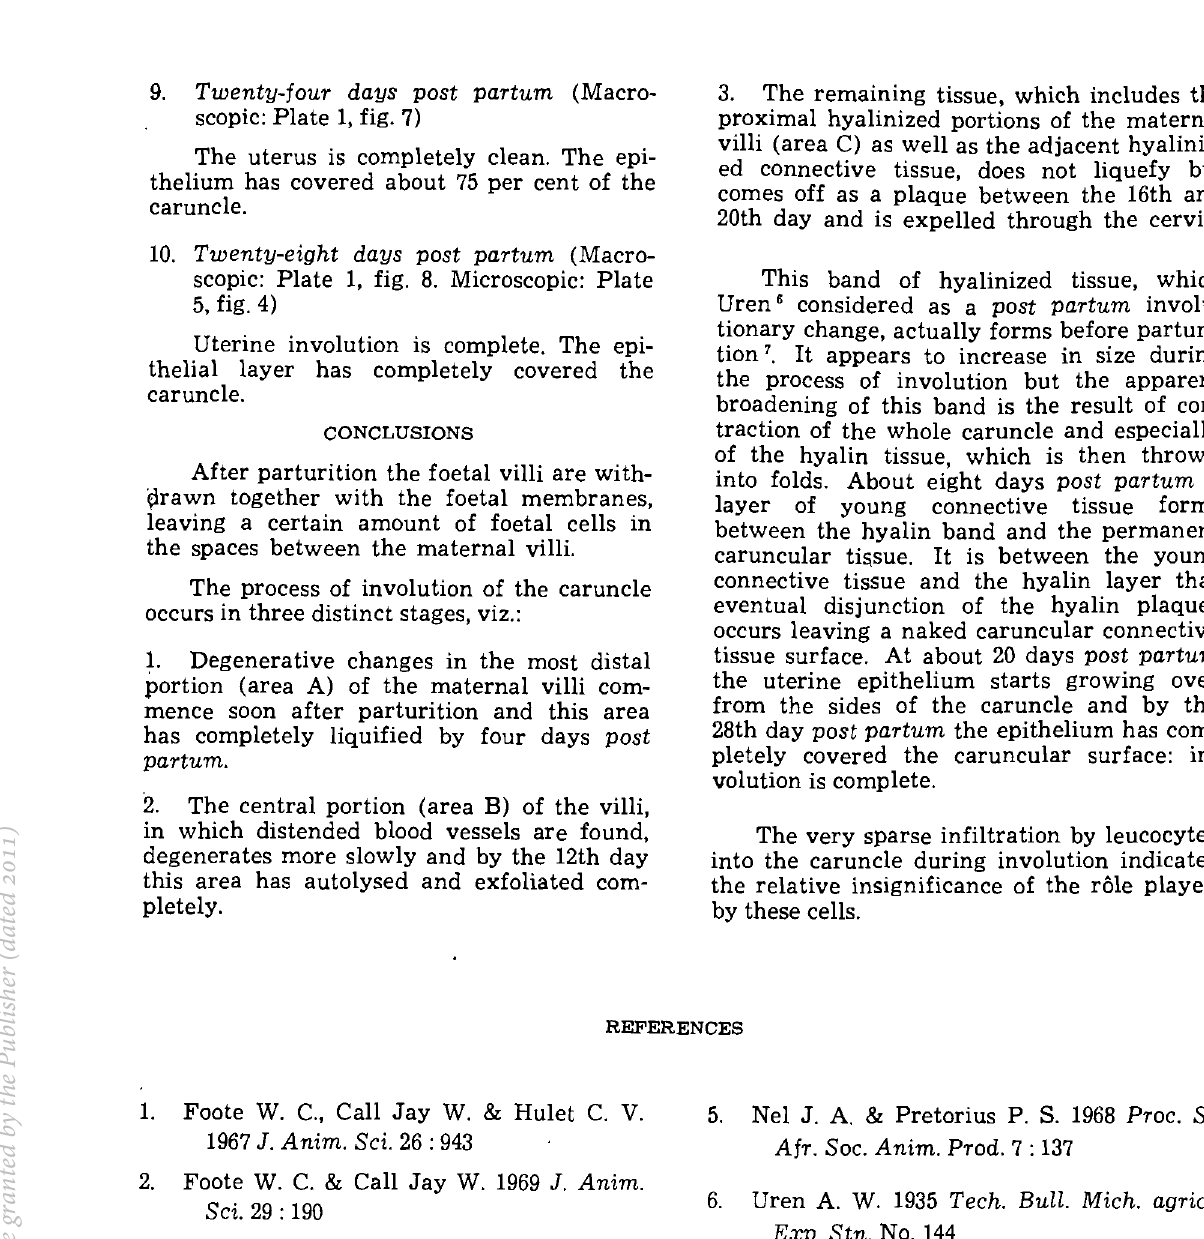
connective tissue